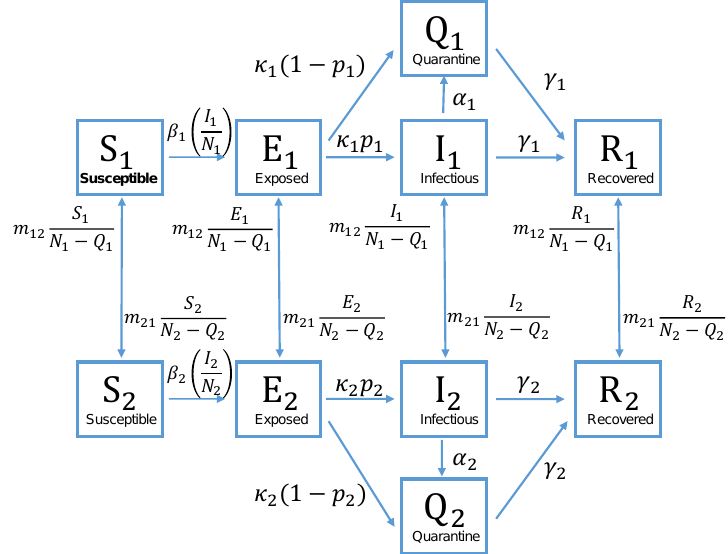
Figure 4. The flow chart of a two-patch model for COVID-19 transmission dynamics is displayed; patch 1 represents Daegu and Gyeongbuk and patch 2 represents the rest of South